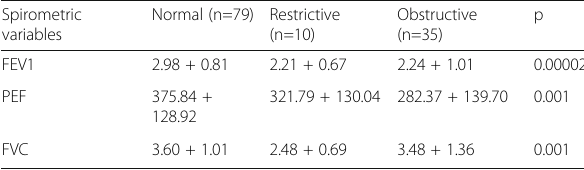
Table 70 (abstract A212). Spirometry Results